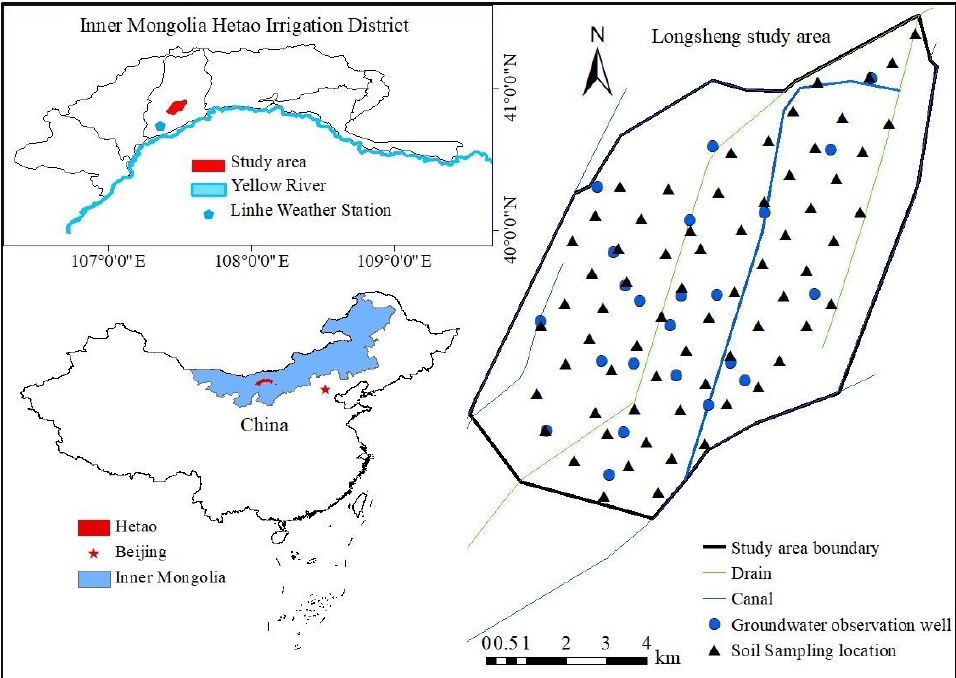
Figure 1. Location of Longsheng Irrigation District, groundwater observation wells, and soil salt sampling locations in the study area.